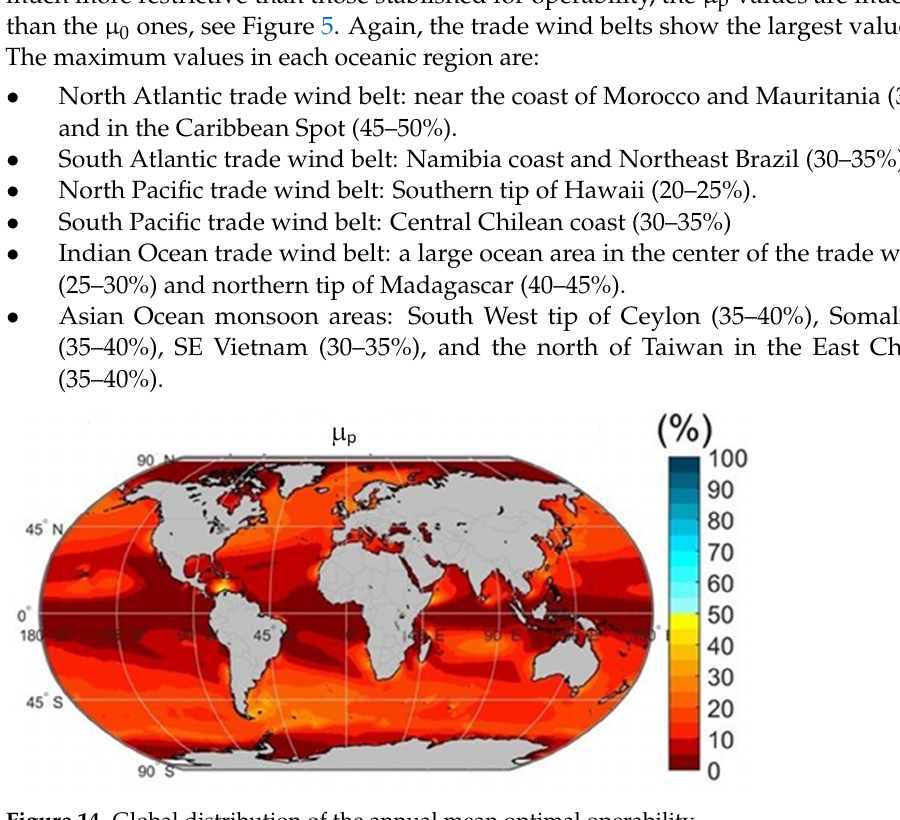
Figure 14. Global distribution of the annual mean optimal operability.